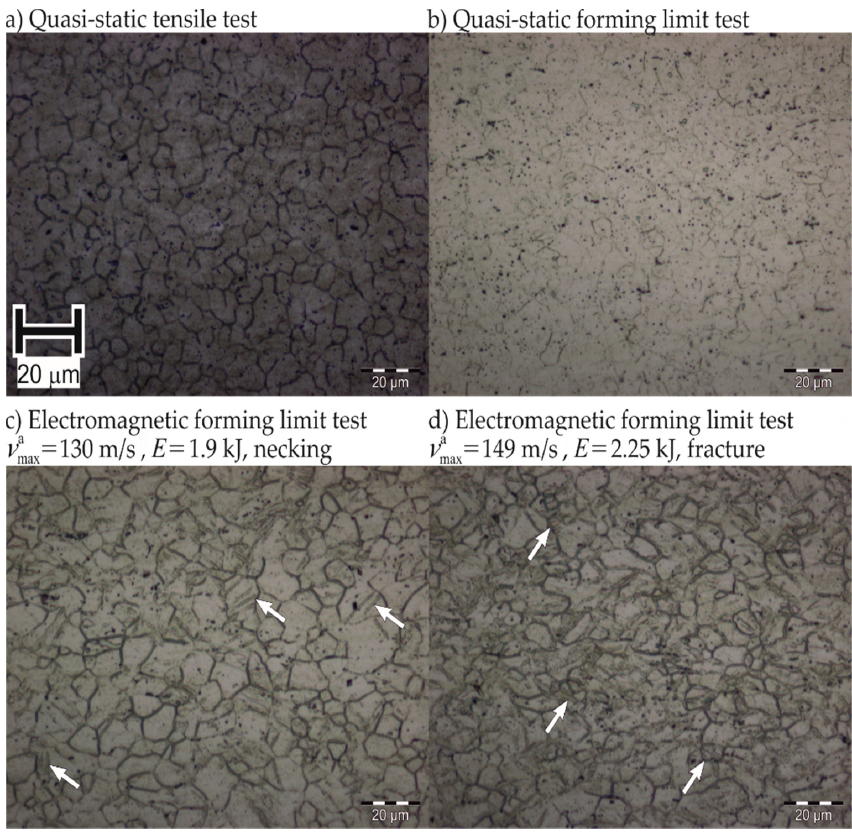
Figure 27. Polished micrographs of Mg AZ31-O deformed under uniaxial tension. Arrows show the twinning spots. E denotes input energy, 𝑣 (cid:3040)(cid:3028)(cid:3051)(cid:3028) denotes maximum apex velocity.